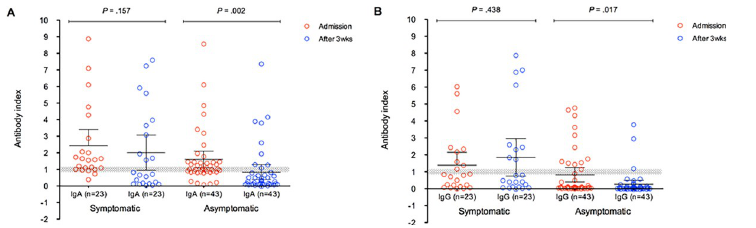
Fig 1. Seroprevalence of COVID-19 in the military police of Rio Grande do Sul.